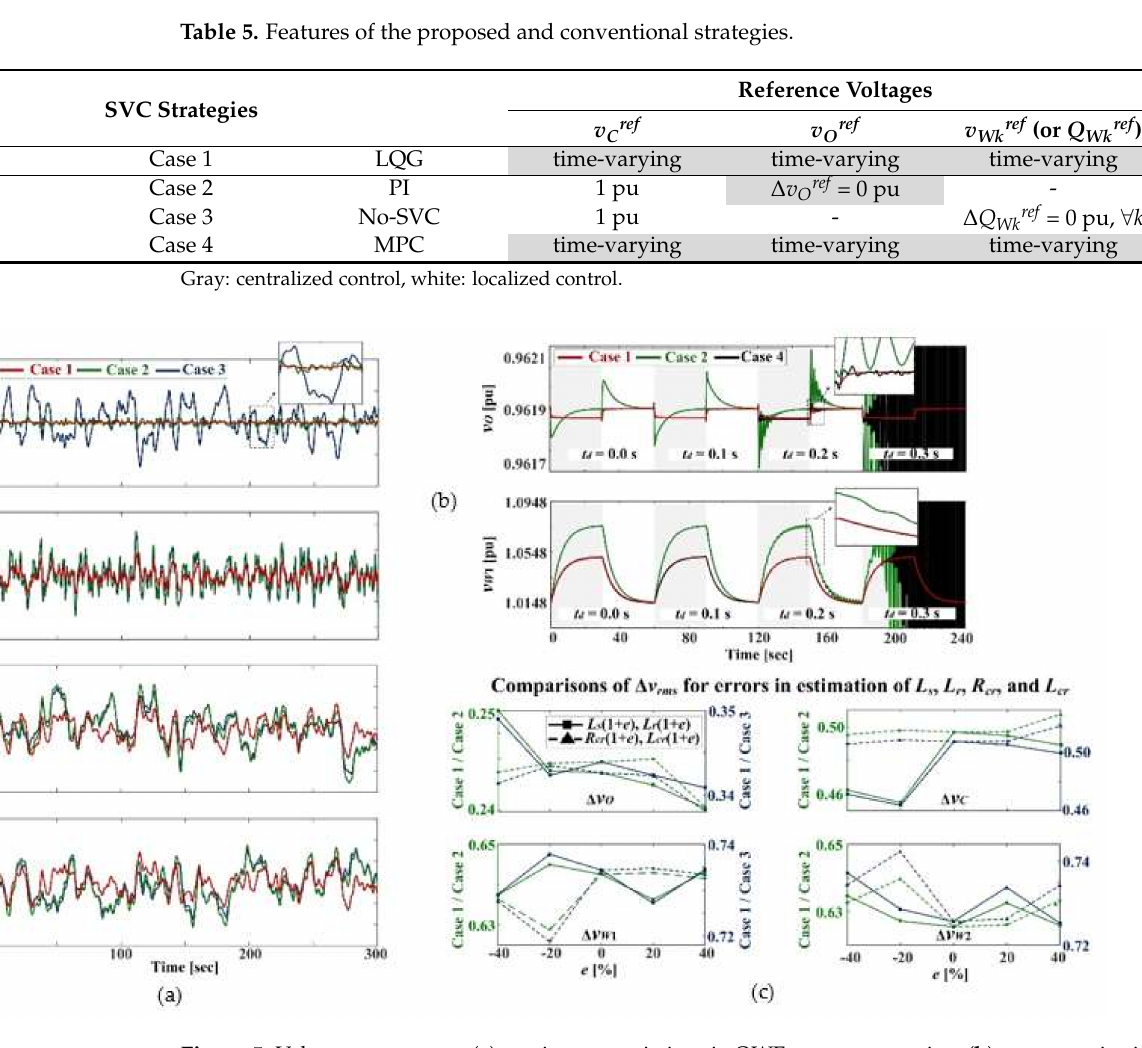
Figure 5. Voltage responses to ( a ) continuous variations in OWF power generation, ( b ) a communication time delay t d , and, ( c ) uncertainties in inductance and resistance parameters when a novel SVC strategy (Case 1) and conventional PI- and MPC-based SVC strategies (Cases 2 and 3) were applied. In ( a ), v O and v C are the POC and PCC voltages, respectively, and v W 1 and v W 2 are the OWF terminal